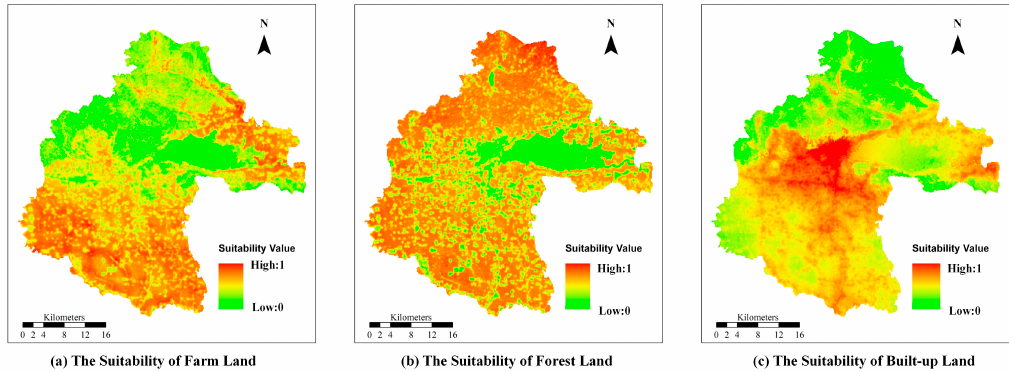
Figure 10. Land-use suitability in the experiment area (the suitability data are adapted from [33]).(a) The suitability of Farm Land; (b) The suitability of Forest Land; (c) The suitability of Built-up Land